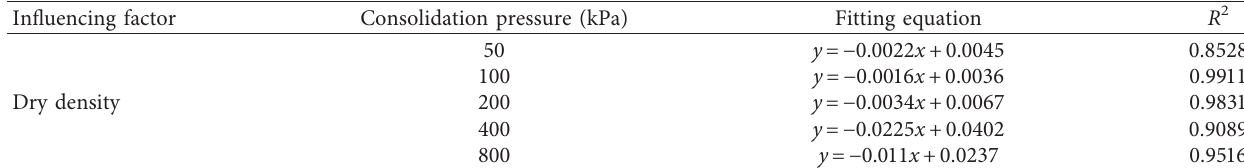
Table 10: Regression analysis equation under the influence of dry